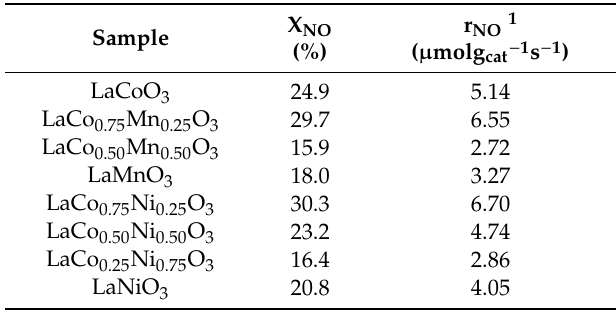
Figure 6. Conversion of NO over LaCo 1 – x Mn x O 3 as a function of temperature. Table 2. NO oxidation activity of perovskites at 350 °C.